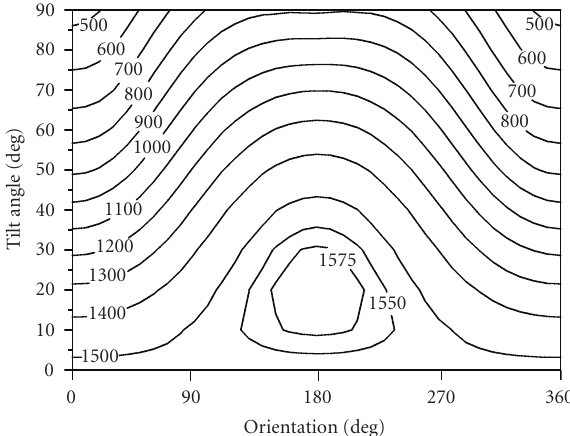
Figure 5: Annual total solar yield (kWh/m 2 ) for various tilt angles and orientations.